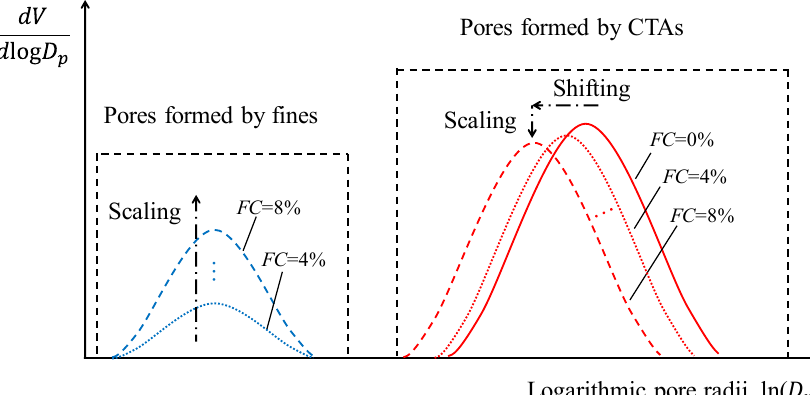
Figure 5. A conceptual model considering the change in PSD as FC increases.